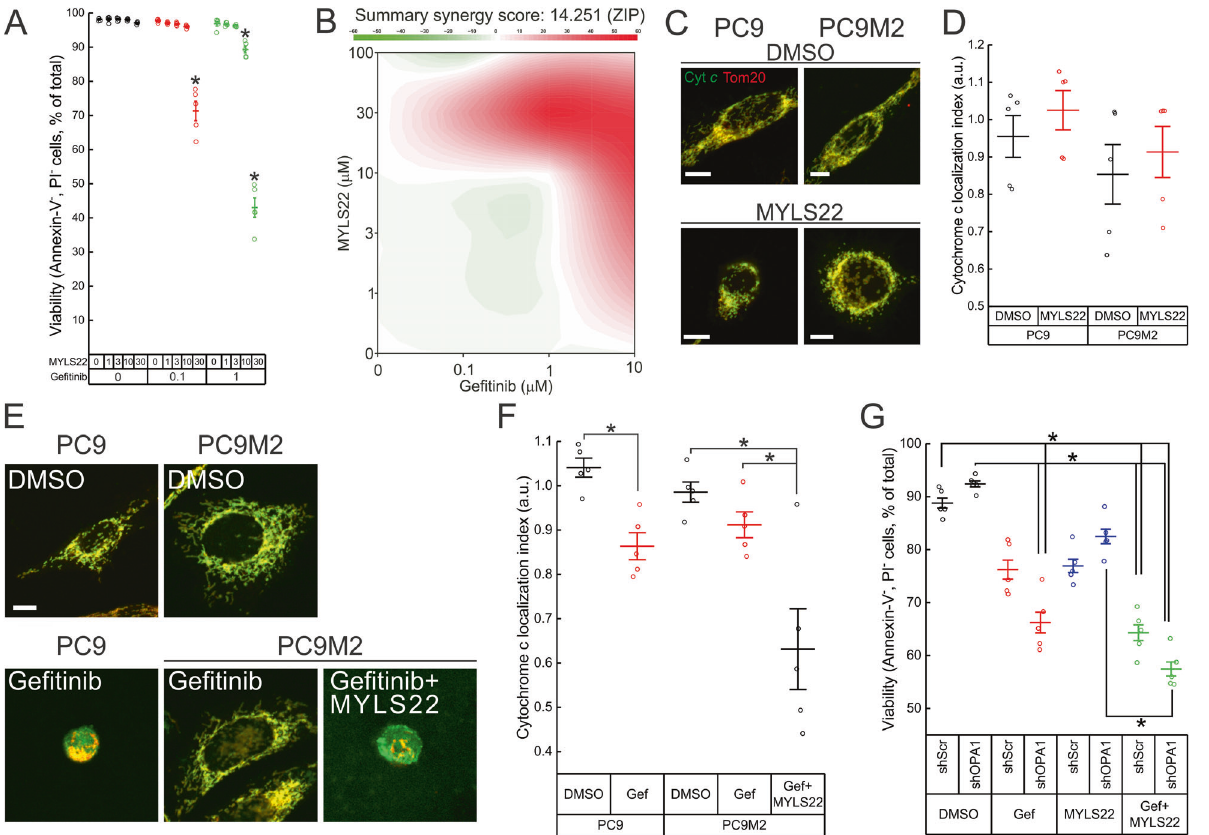
Fig. 4 MYLS22 synergizes with ge fi tinib to induce Opa1-dependent mitochondrial apoptosis in PC9M2 cells. A PC9M2 cells were treated with the indicated concentrations of the indicated compounds and viability was assessed by Annexin-V/PI staining. Data